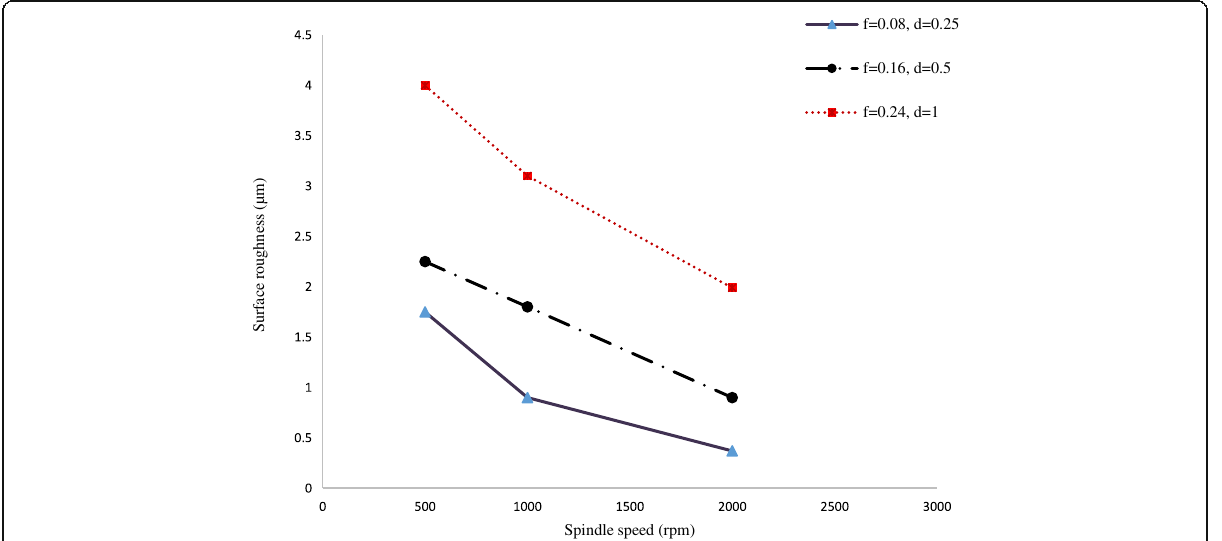
Fig. 3 The spindle speed effect on the surface roughness under different machining conditions